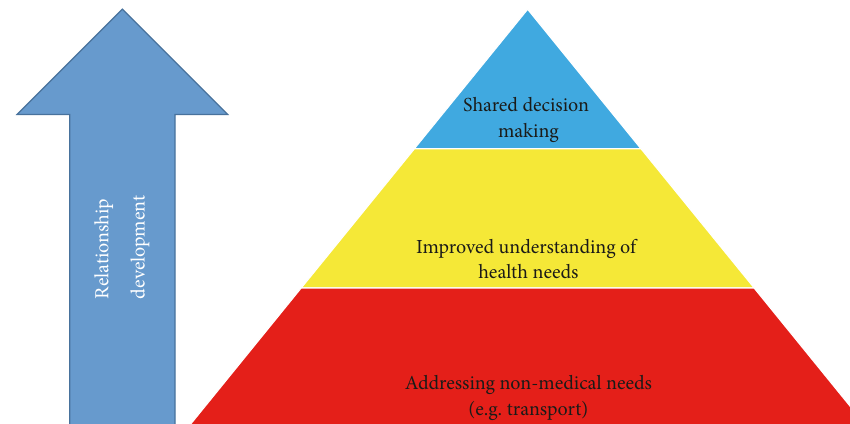
Figure 1: If nonmedical needs are met or at least acknowledged there can be better understanding of health needs, which in turn leads to easier shared decision-making. Relationship development will facilitate each